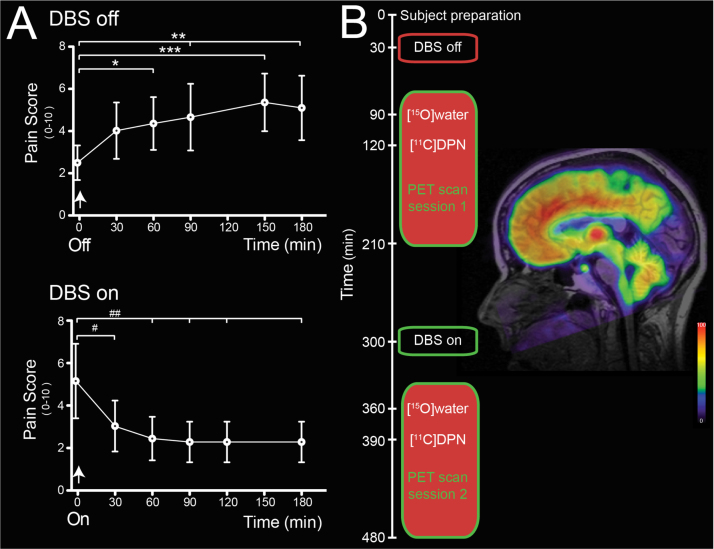
Acute analgesic effects of DBS and change in [11C]DPN binding. (A) Change in pain scores with DBS stimulation assessed during home trial. The analgesic effect of stimulation was almost completely lost 60 min after inactivation of DBS (pain VAS increased from 2.5±0.8 to 4.4±1.3, p<0.05, n=5) to reach a plateau level of pain that continued for more than two hours. On re-commencing PAG stimulation the analgesic effect was evident within 30 min (pain VAS reduced by 41% from 5.1±1.8 to 3.0±1.2) and this analgesic action was maintained for the rest of the test period. (rm-ANOVA with Dunnett's posthoc tests, *,# – p<0.05; **, ## – p<0.01, ***,### – p<0.001.). (B) Timeline of the sequential [15O]water and [11C]DPN scans with the first scanning session following 60 min after DBS was stopped and the second commencing 60 min after DBS was reinstated. Shown alongside is a representative sagittal parametric image of the volume of distribution (VT) for [11C]DPN overlaid on T1-weighted MRI image for a single subject (h00635) with DBS off. The image shows a characteristic distribution of the opioid ligand with high binding in the thalamus, midbrain and in several cortical regions (such as prefrontal and cingulate) but low binding in the occipital cortex and the pontine nucleus.